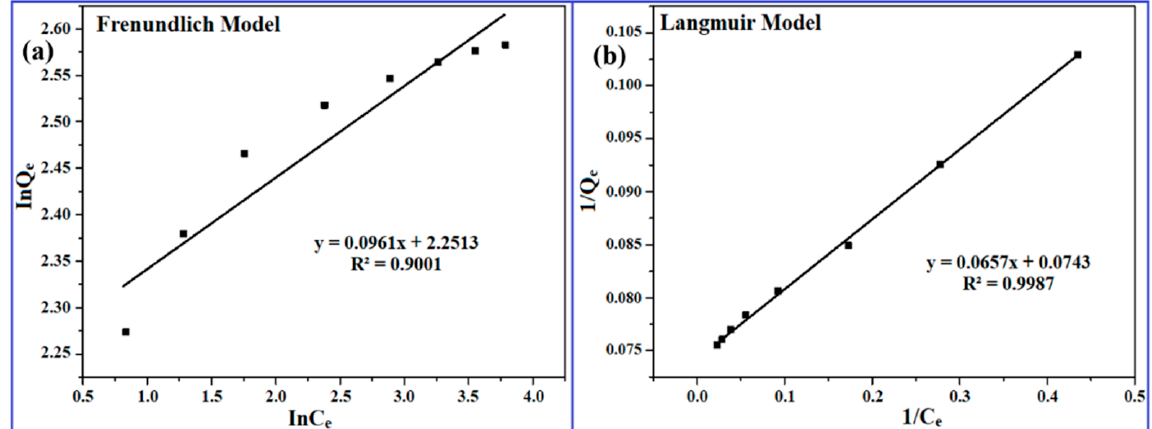
Figure 6. ( a ) Freundlich and ( b ) Langmuir adsorption isotherm curves using Al-GNSC adsorbent. The linear forms and adsorption isotherm data for the two models are presented